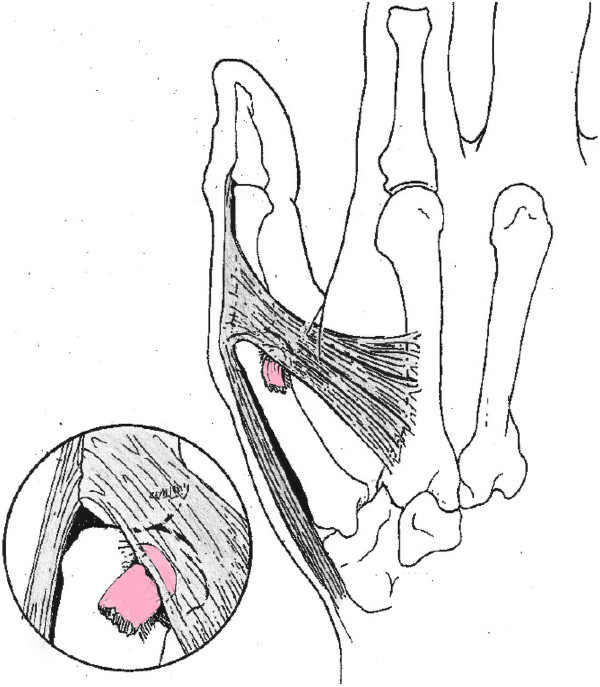
A Stener lesion.